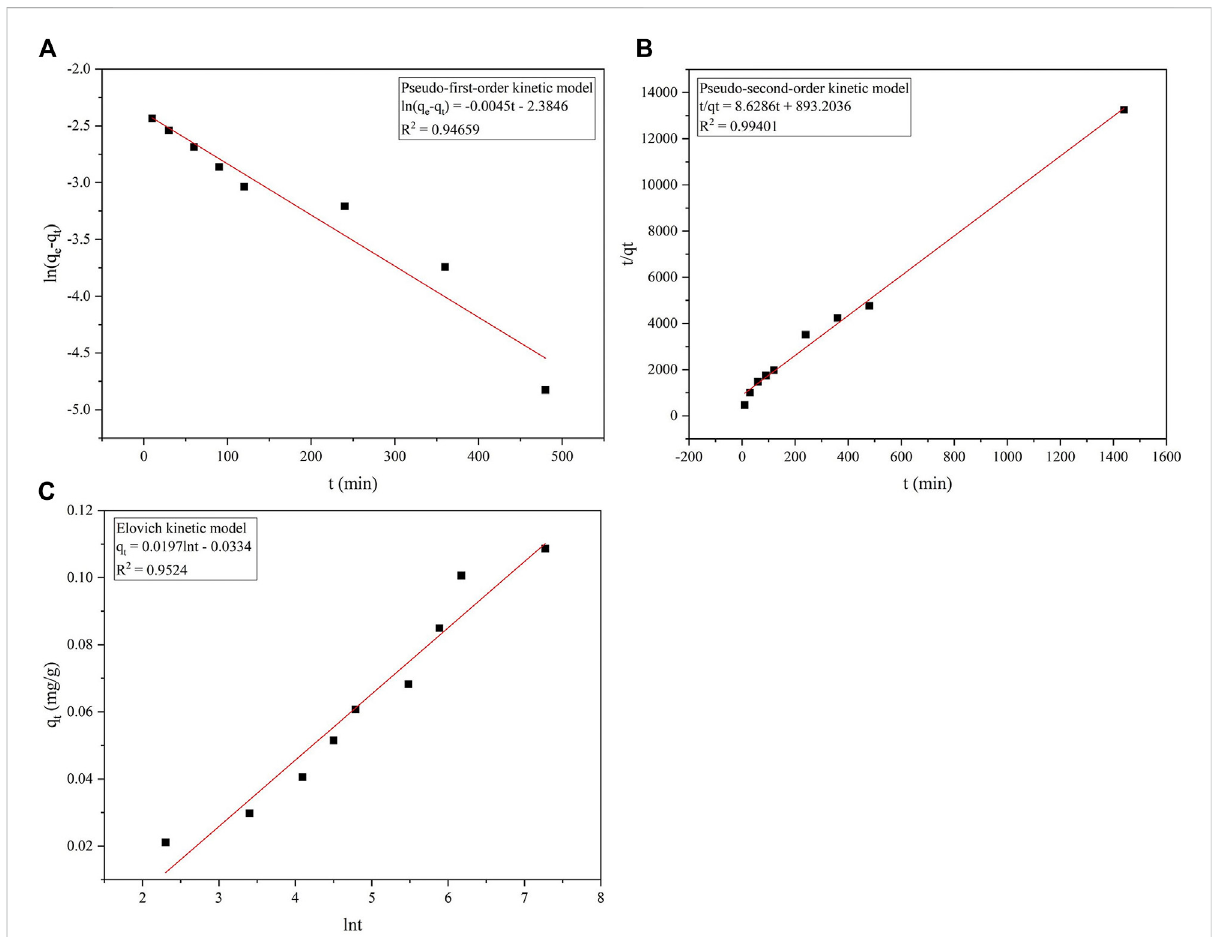
FIGURE 5 Fittingoftheadsorption kineticmodelofphosphoruson theceramsite loadedwith nano-iron. (A) thepseudo- fi rst-orderkinetic model; (B) the pseudo-second-order kinetic model; (C) the Elovich kinetic model.